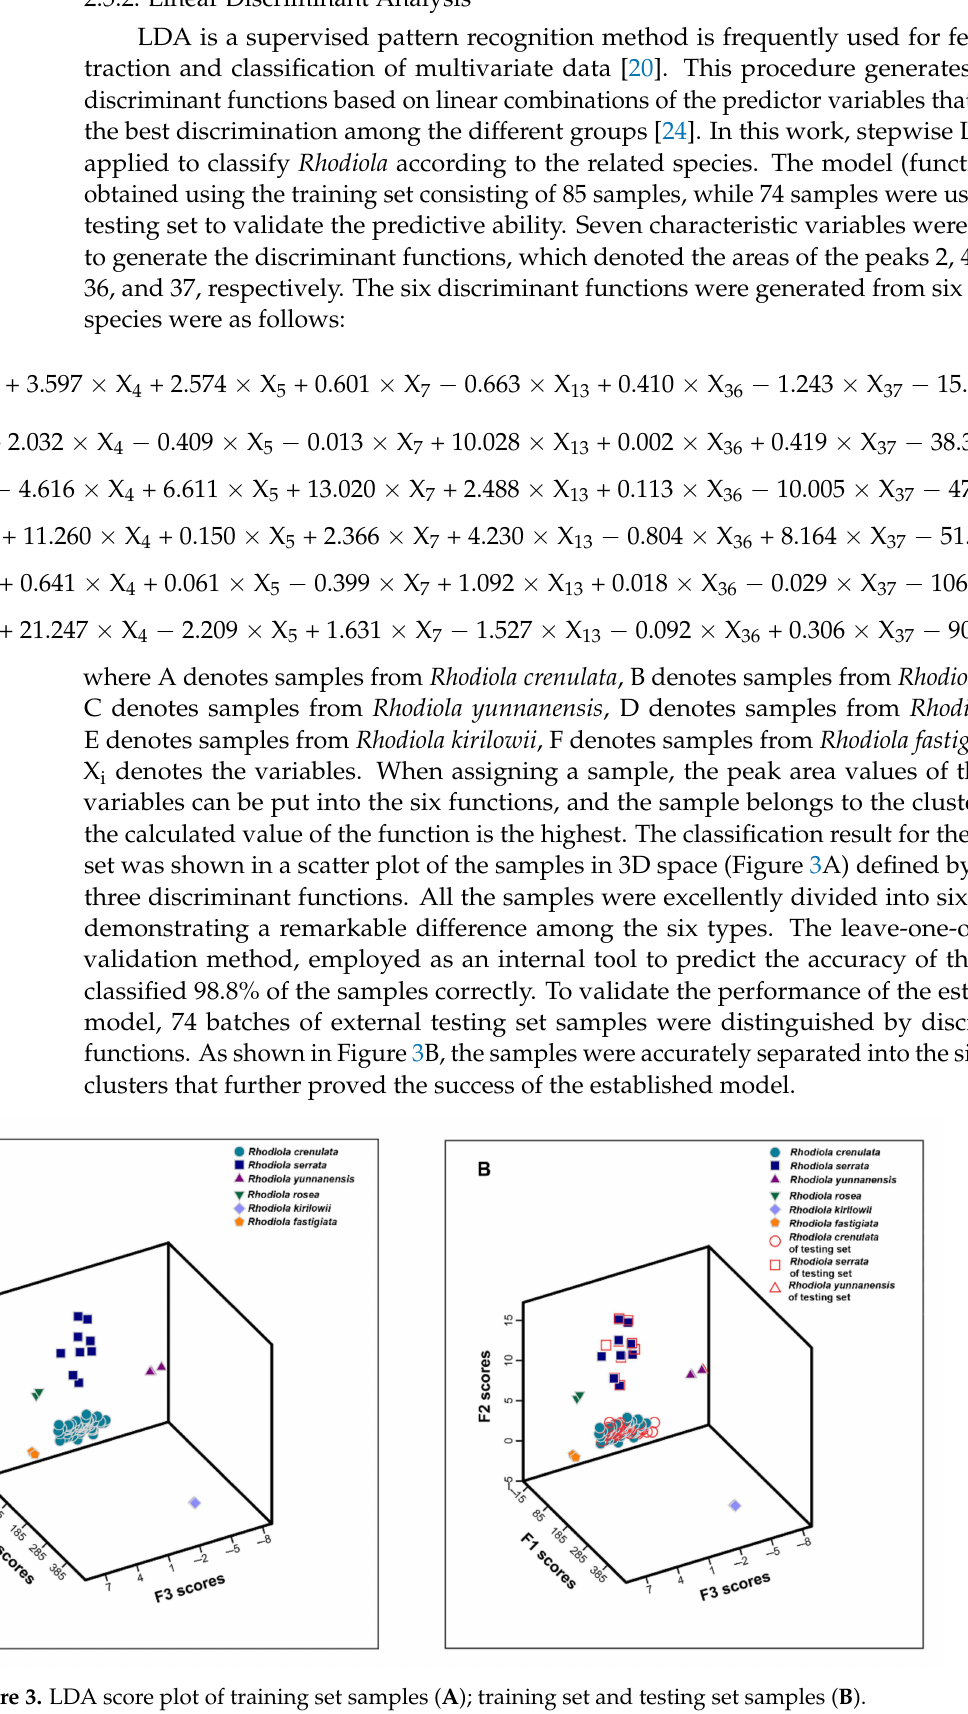
Figure 3. LDA score plot of training set samples ( A ); training set and testing set samples ( B